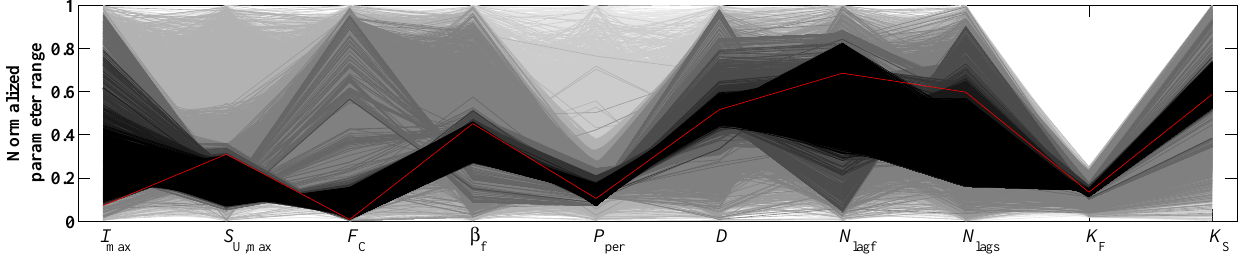
Figure 5. Normalized parameter plot for FLEX A . Darker colors indicate parameter sets that satisfy larger numbers of process constraints. The red trajectory indicates θ best .